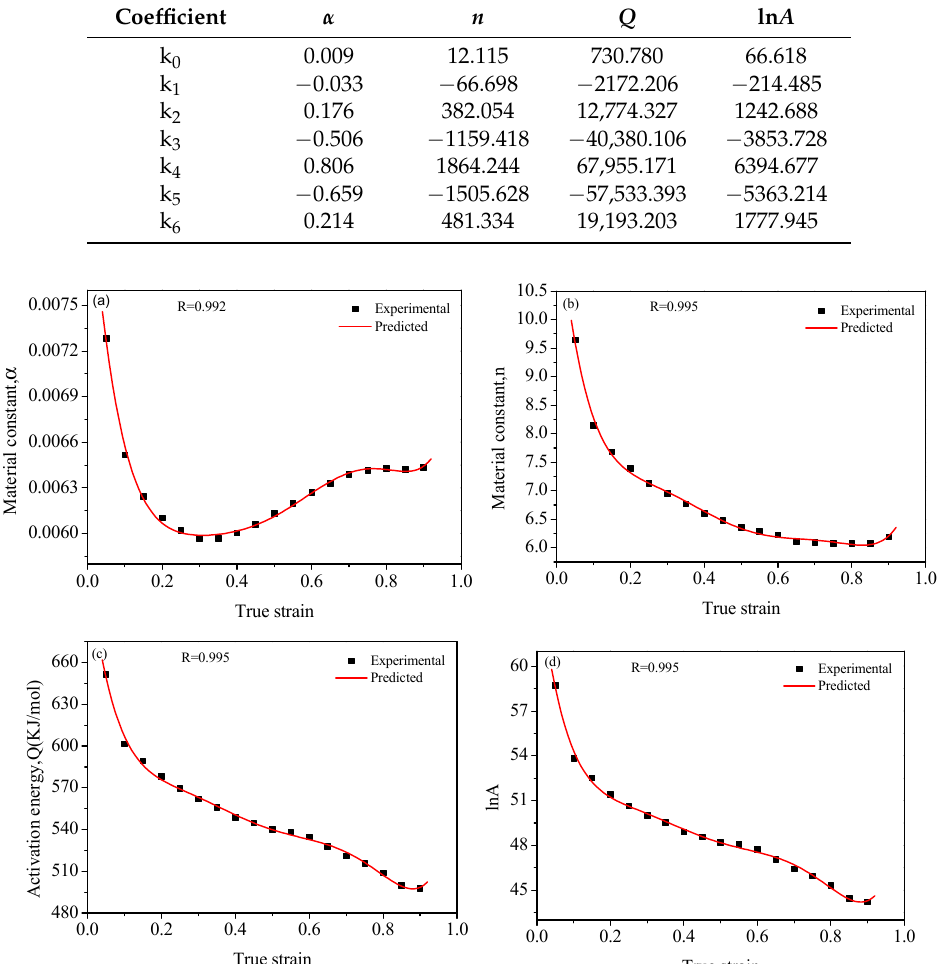
Figure 5. Variation of ( a ) α , ( b ) ln A , ( c ) n and ( d ) Q with true strain for the H13-mod steel. Table 4. Polynomial fitting results of a , n , Q and ln A for the H13-mod steel.